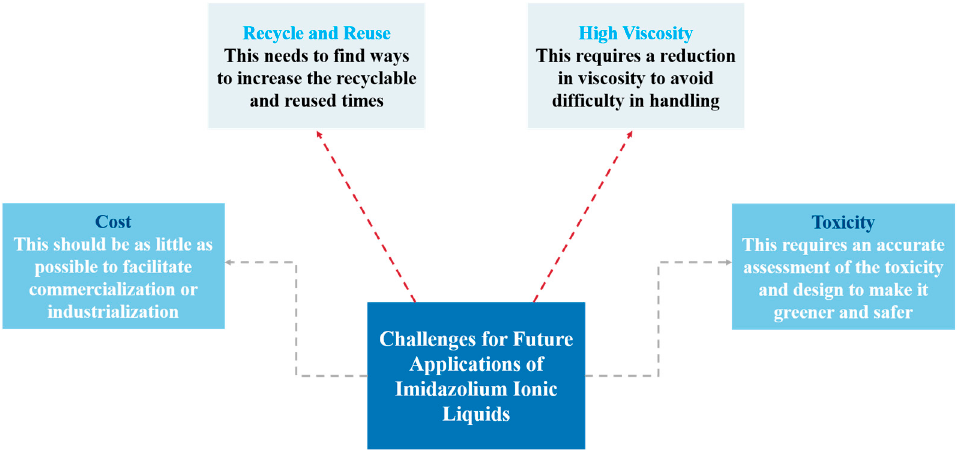
Figure 4. Overview of challenges for future applications in imidazolium ionic liquids.